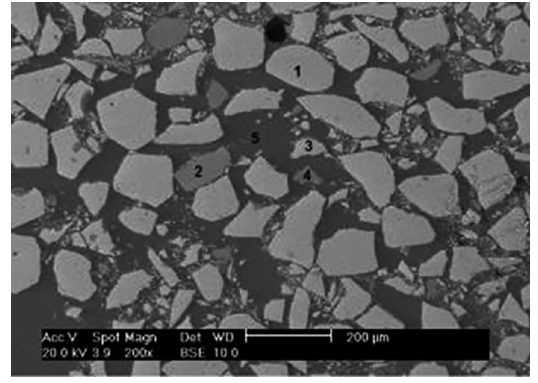
Figure 1: SEM of the chromite ore. Chromite particles (lighter) and gangue (darker).